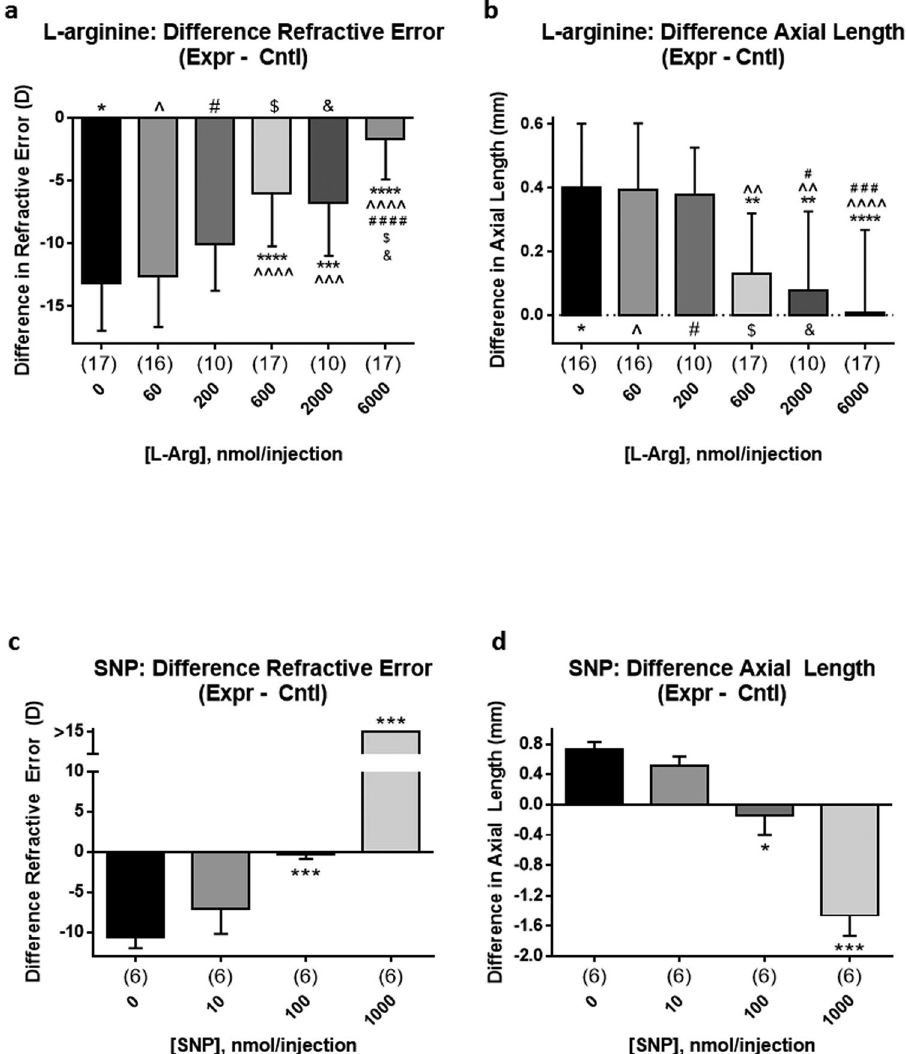
Figure 2. The effects of exogenous nitric oxide (NO), delivered intravitreally as NOS-substrate (L-arginine; L-Arg) or NO-donor (sodium nitroprusside; SNP), on form-deprivation myopia in chicks; doses represent the molar amounts of drug injected, per injection, 3 times at 48-hr intervals. L-Arg ( a,b ) and SNP ( c,d ) dose- dependently inhibited the development of myopic refractive error ( a,c ) and excessive axial elongation ( b,d ) in goggled chick eyes; the refractions and sizes of control eyes were not affected by drugs delivered to the goggled eyes. Symbols: asterisk ( * ): comparison to effect of PBS-treatment; caret (^): comparison to 60 nmol; pound (#): comparison to 200 nmol; dollar ($): comparison to 600 nmol; ampersand (&): comparison to 2000 nmol. Statistics: •••• p < 0.0001, ••• p < 0.001, •• p < 0.01, • p < 0.05; L-Arg: One-Way ANOVA + Tukey’s post-hoc; SNP: Kruskal-Wallis + Dunn’s post-hoc. Data are represented as the means of the difference in values for the experimental eye minus those for the control eye, ± SD; sample sizes (n) are denoted in brackets below each